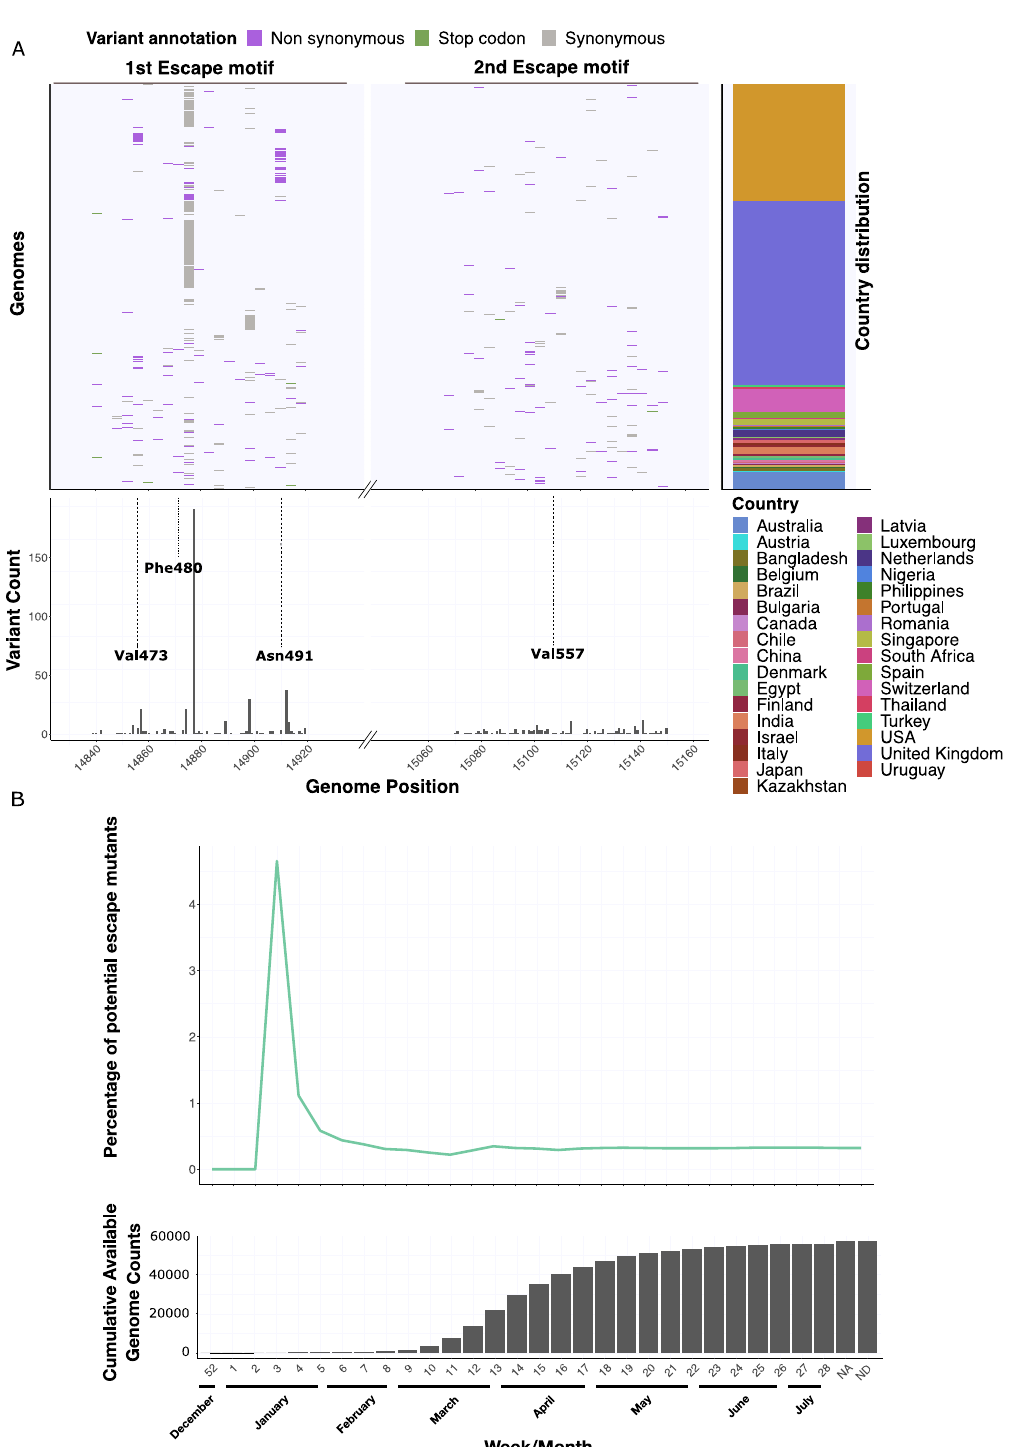
Figure 1. Potential escape mutations inside 1st and 2nd escape motif are not uniformly distributed, they are rare worldwide and stable overtime: ( A ) Mutation prevalence in the two potential escape motifs, SNPs are highlighted in the upper genome panel, their frequency in the lower variant count panel, the genome origin is depicted in the upper right country distribution panel. ( B ) Frequency changes of potentially resistant genomes over time become stable after the 13th calendar week in 2020 and settle to 0.32%. The cumulative count panel displays available genomes on GISAID at a defined week. The time frame considered spans from 25th of December 2019 till 12th of July 2020, NA indicates no date information available, ND indicates incomplete date information available.